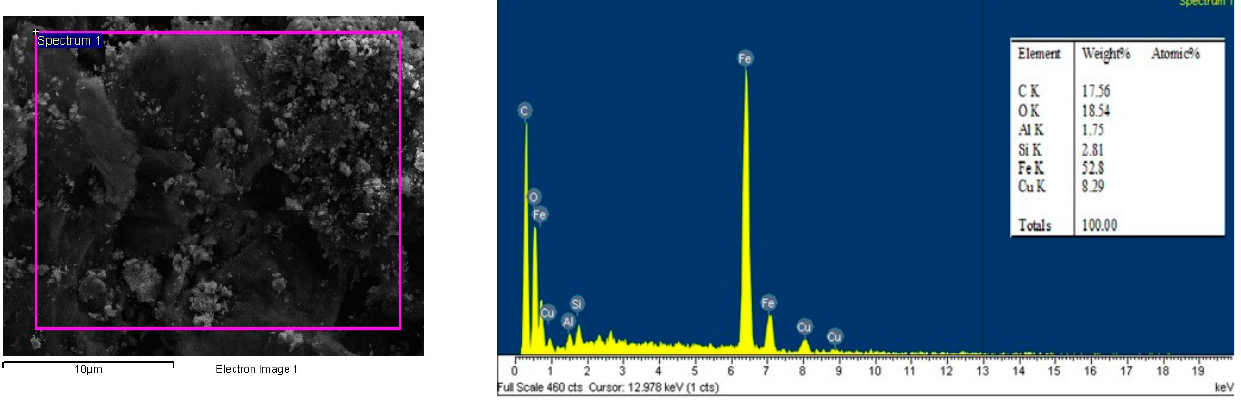
Figure 6. EDX results of CuFe 2 O 4